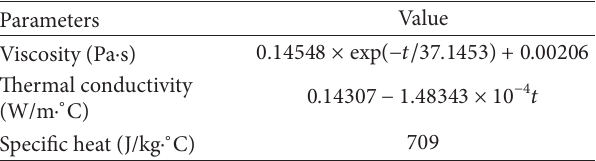
Table 3: Physical parameters of